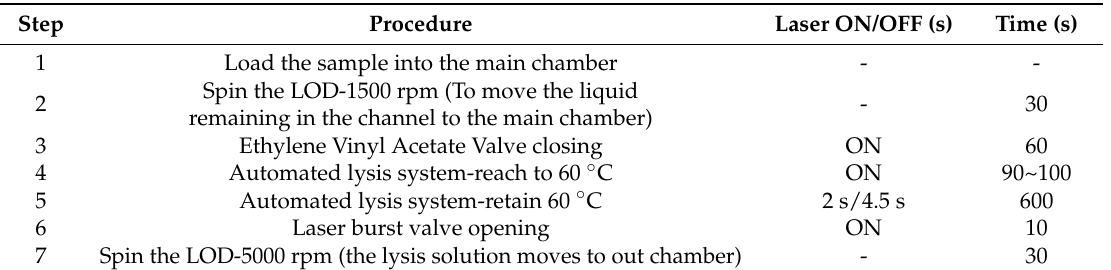
Table 1. Summary of the experimental procedure of the LOD platform for DNA